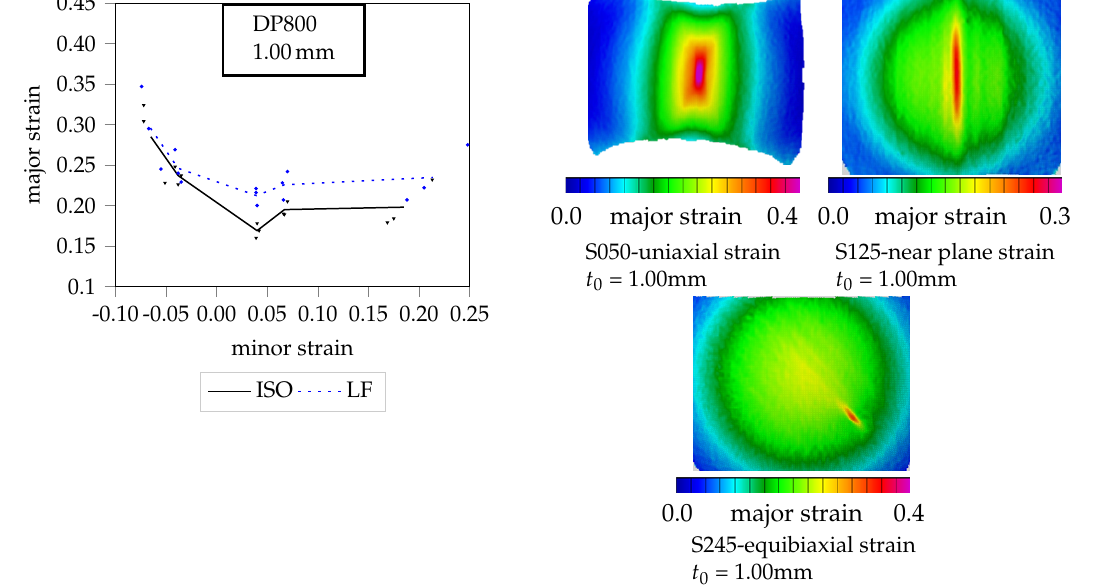
Figure 3. FLC of DP800 with Aramis visualizations of the strain distributions one step before